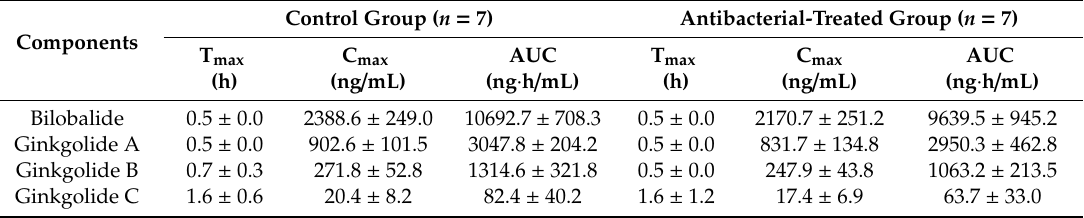
Figure 3. The profiles of the mean plasma concentration of terpene lactones over time after administration of 600 mg/kg ginkgo leaf extract in control and ciprofloxacin-treated mice. Mean plasma concentration–time profiles of ( A ) bilobalide ( B ) ginkgolide A, ( C ) ginkgolide B, and ( D ) ginkgolide C. Table 2. Pharmacokinetic parameters of terpene lactones after oral administration of ginkgo leaf extract in control and ciprofloxacin-treated